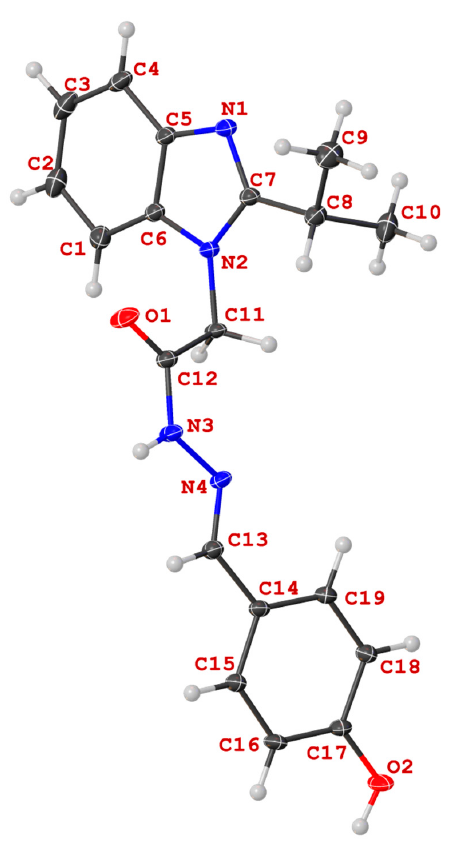
Figure 6. Molecular structure of N '-((4-hydroxyphenyl)methylidene)-2-(2-(propan-2-yl)-1 H - benzimidazol-1-yl)acetohydrazide ( 13c ) in the crystal.